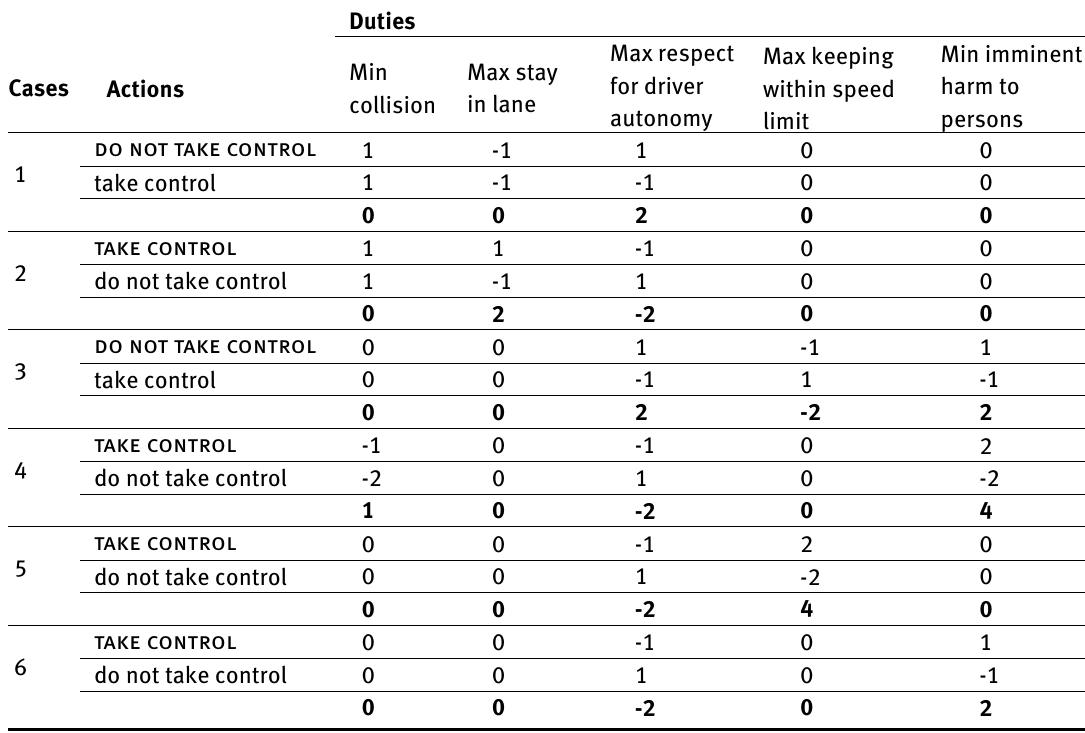
Table 1: Assisted driving dilemma case satisfaction/violation values and